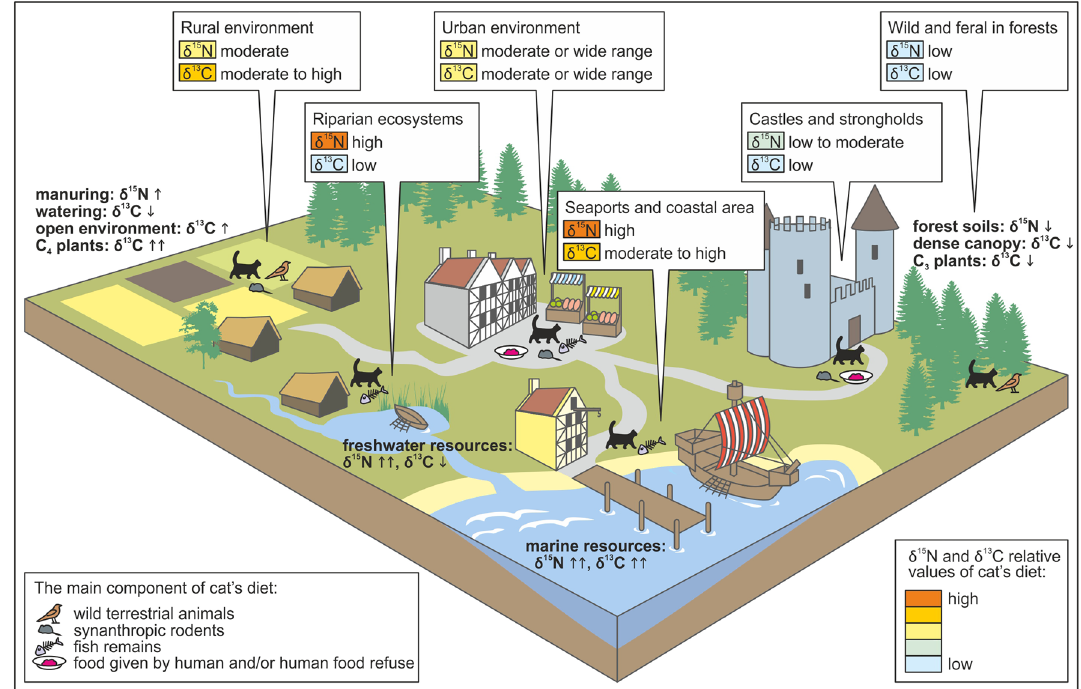
Figure 7. Concept of the variability of carbon and nitrogen isotope signal in cats in typical medieval and post- medieval anthropogenic